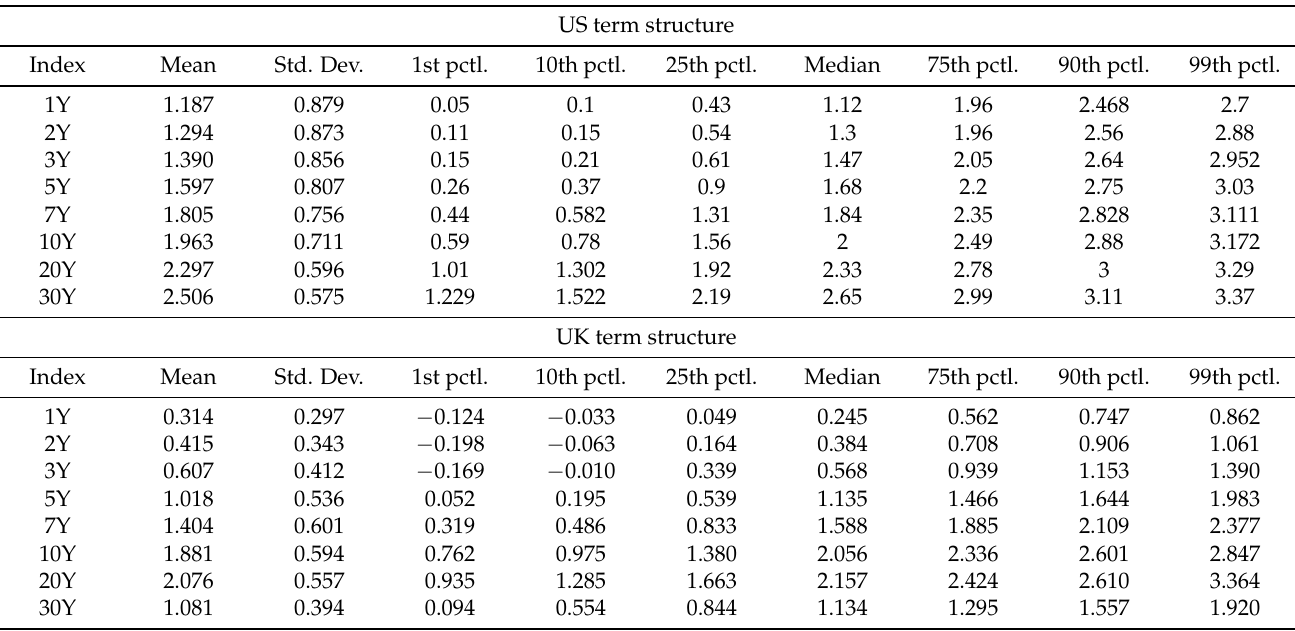
Table 1. Statistics for the historical term structure of the three countries. (pctl.: percentile). US term